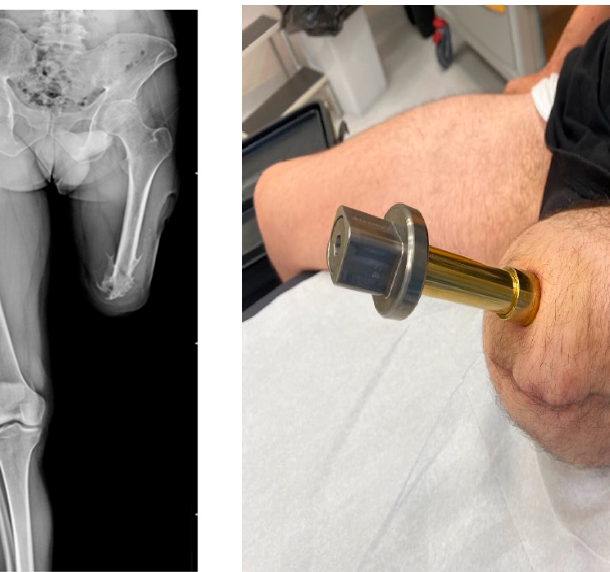
Figure 2. X-ray front view ( left ), bone-prosthesis connection after the second surgical step ( middle ), patient wearing the prosthesis at one-year follow-up ( right ).